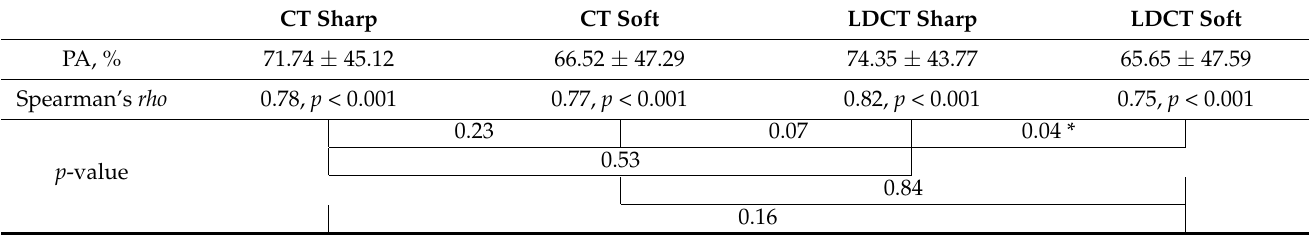
Table 1. Inter-observer agreement for matched patient data.